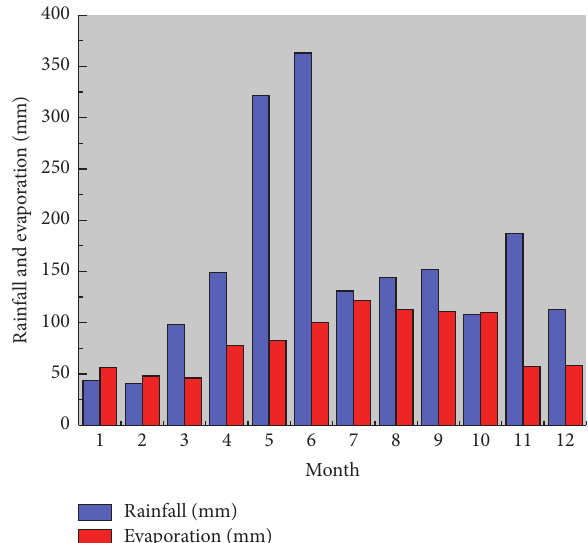
Figure 5: Monthly average rainfall and evaporation in Liuzhou.